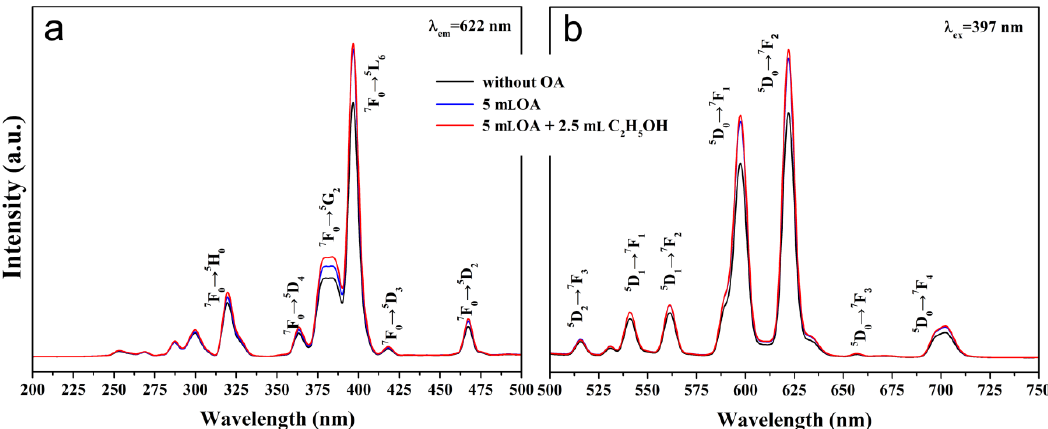
Figure 5. Excitation ( a ) and emission ( b ) spectra of the β -NaYF 4 :Eu 3 + crystals prepared without OA, with 5 mL OA, and with 5 mL OA + 2.5 mL C 2 H 5 OH.